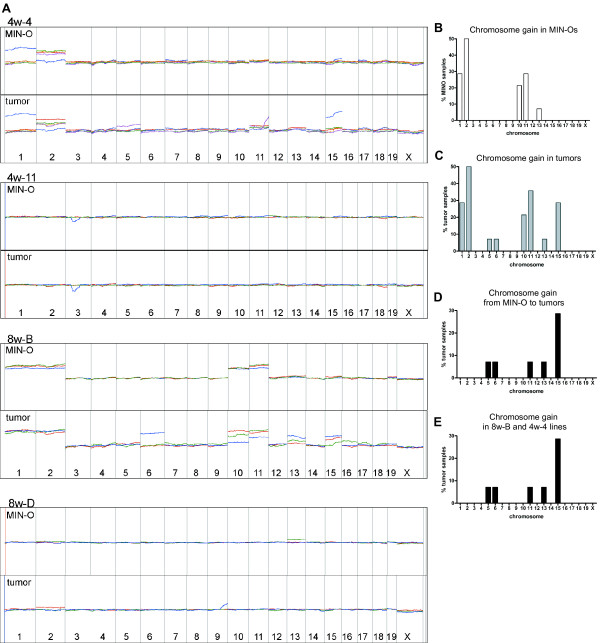
Mouse whole genome CGH microarray data from MIN-Os and tumors. A) Summary of array CGH data by MIN-O lines. Agilent mouse whole genome CGH microarray was used for genomic DNA from different MIN-O and tumor pairs from 4w-4, 4w-11, 8w-B and 8w-D MIN-O mice. The graphs were generated with a smoothing average of 50 MB. Each Pair of MIN-O and corresponding tumor from the same animal is represented with the same color (n = 4 for 4w-4, n = 3 each for 4w-11, 8w-B and 8w-D). 4w-4 and 8w-B samples have multiple whole chromosome gains. 4w-11 and 8w-D samples are relatively genetically stable. B-E) Frequency of whole chromosome gains found in MIN-Os and tumors by array CGH. B) Distribution of whole chromosome gains in all MIN-Os studied with array CGH (n = 14). The most frequent gain is found on chromosome 2, followed by chromosome 1 and 11. C) Distribution of chromosome gains in all tumor samples studied with array CGH (n = 14). Tumors have the same whole chromosome gains found in MIN-Os with a few additional gains. D) Frequency of whole chromosome gain events associated with MIN-O to tumor transition. Whole chromosome gains in tumors that are not found in the corresponding MIN-O samples are presumed to be acquired during the transition from MIN-O to tumor. E) Frequency of chromosome gains in 8w-B and 4w-4 samples (n = 8 for MIN-Os and tumors each). The majority of whole chromosome gains were found in the 8w-B and 4w-4 MIN-O lines.